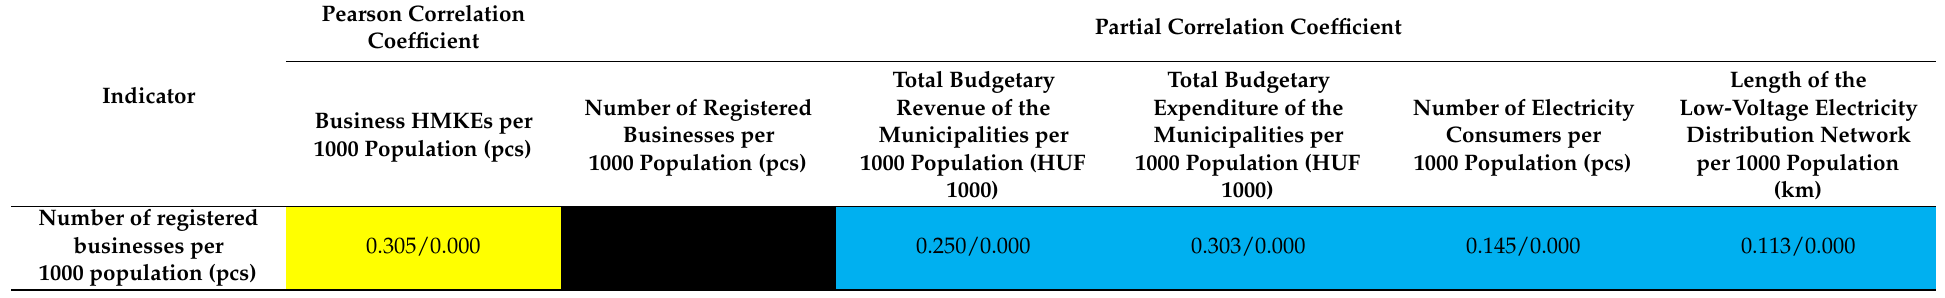
Table A3. The strengths of the relationships between the quantity of the business HMKEs per 1000 population and the settlement indicators 1 ( 1 Pearson correlation coefficient/ p -value; if p < 0.05, then there is a significant verified relationship between the two variables) (In the case of the Pearson correlation coefficients in the table grey background indicates weak correlations and yellow means weak moderate ones. In the case of the partial correlation the red background indicates a partially distorted correlation, blue signals partial explanation (the controlled variable explains the relationship between variables i and j only partially), while the black one shows irrelevant